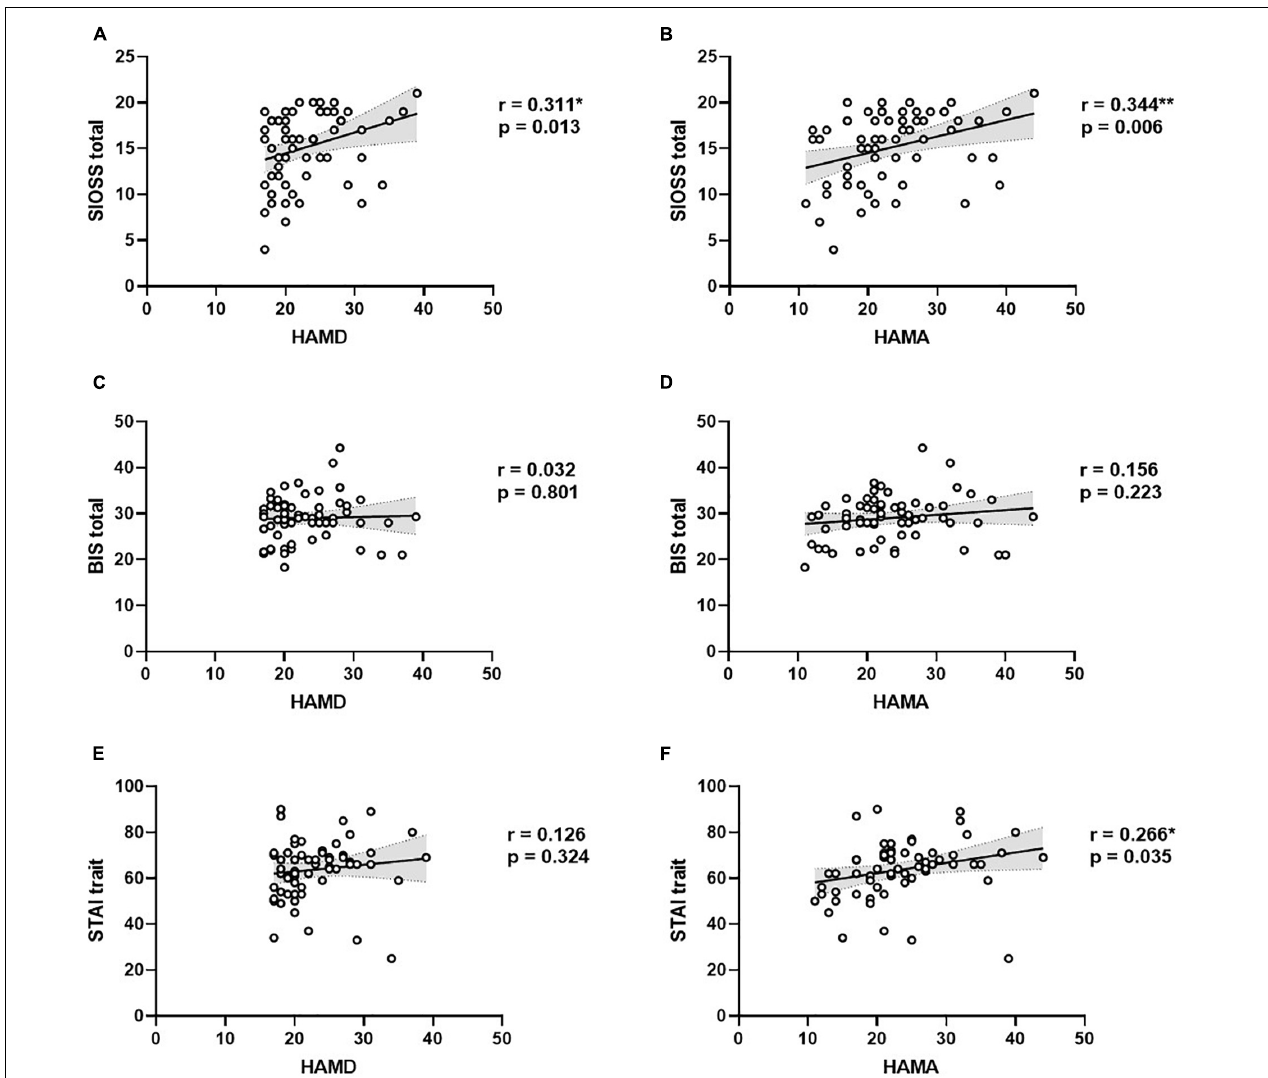
FIGURE 3 | Correlations between clinical indexes and symptom severity in MDD. (A) Correlation between suicidal ideation and depression severity; (B) Correlation between suicidal ideation and anxiety severity; (C) Correlation between impulsivity and depression severity; (D) Correlation between impulsivity and anxiety severity; (E) Correlation between trait anxiety and depression severity; (F) Correlation between trait anxiety and anxiety